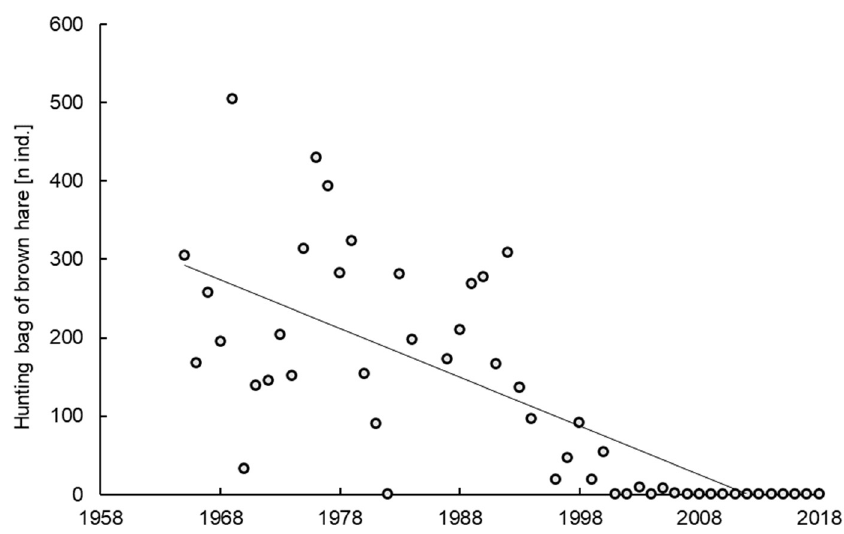
Figure 3. Decrease in the annual hunting bag of brown hare in the study area (Rogów, central Po- land).